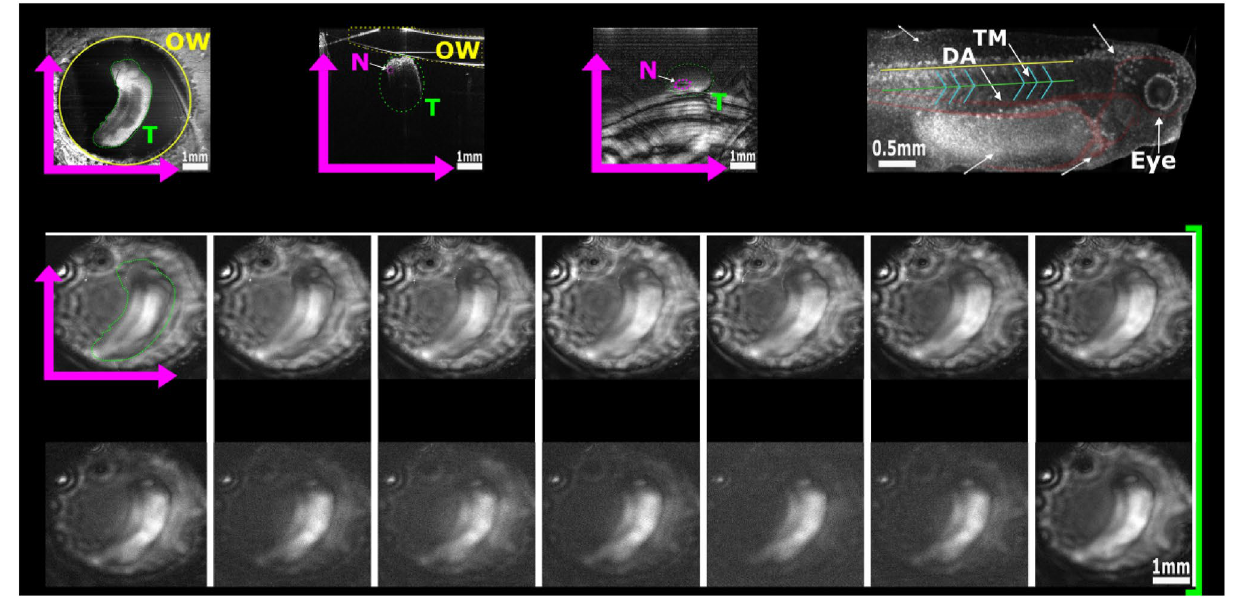
Figure 5. Representative in vivo OS-PAM en face images of one tadpole (T) generated at various wavelengths across the whole emission spectrum of the OS1. High noise levels can be observed above 1200 nm as water absorption increases. The OCT image has a wider field of view providing an overview of the optical window (OW) and the positioning of the tadpole; Top right: Structural en face OCT image displaying tadpole anatomy with highlighted main veins and aortas (red) as well as, the trunk muscles (blue). The green line indicates the position of the notochord (N) while the yellow line the position of the spinal cord. DF dorsal fin, YS yolk sack, V ventricle. This procedure was repeated on four animals (n = 4).